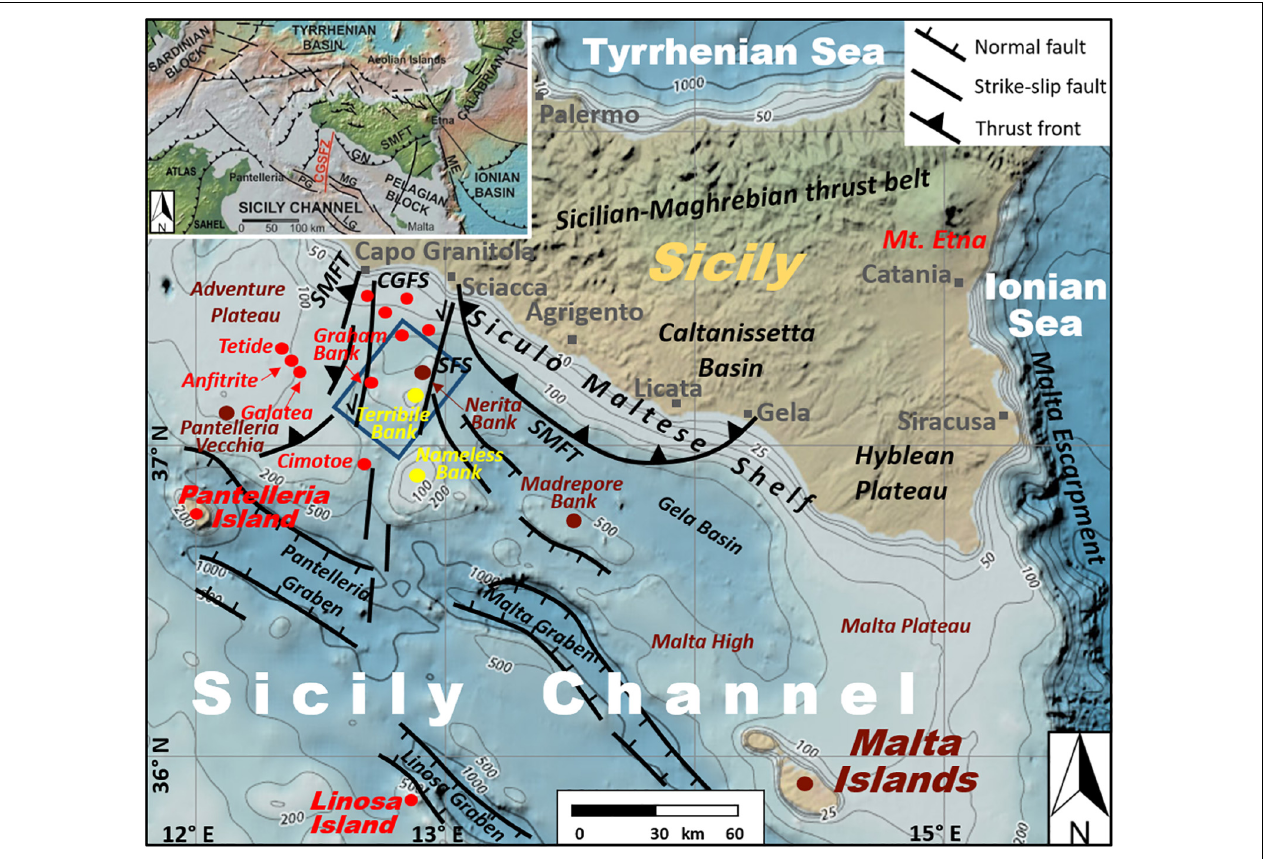
FIGURE 1 | Shaded-relief bathymetric map of the northern portion of the Sicily Channel (from GEBCO-General Bathymetric Chart of the Oceans-Digital Atlas). The blue box shows the study area; the red, brown and yellow circles indicate the location of volcanic centers, sedimentary banks and sedimentary banks with scattered volcanic manifestations on top, respectively (from Calanchi et al., 1989; Civile et al., 2015, 2018; Lodolo et al., 2019a). CGFS, Capo Granitola fault system; SFS, Sciacca fault system; SMFT, Sicilian–Maghrebian fold-and-thrust belt front (from Civile et al., 2018). The inset shows the geodynamic setting of the Central Mediterranean; GN, Gela Nappe; ME, Malta Escarpment; PG, Pantelleria Graben; LG, Linosa Graben; MG, Malta Graben; CGSFZ,Capo Granitola-Sciacca Fault Zone (from Civile et al.,